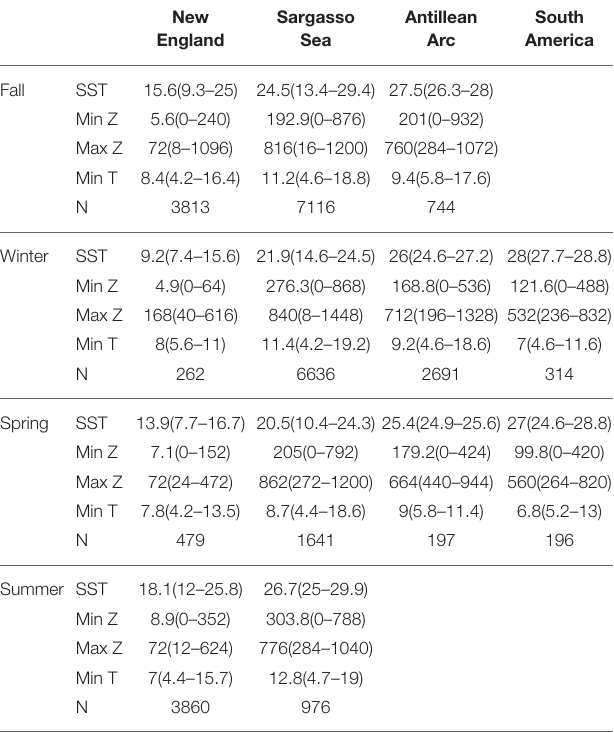
TABLE 2 | Summary statistics for vertical habitat envelopes in Figure 7 by region and